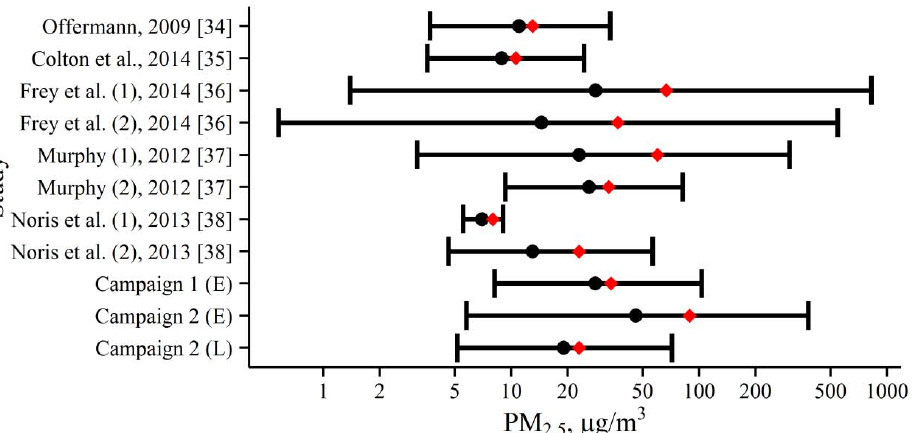
Figure 8. Summary of PM 2.5 concentrations measured in multi-family green buildings. Geometric mean (black circles), mean (red diamonds) and range containing 95 percent of the measurements (whiskers) are shown. Study labels are author (building if multiple green buildings in one study), year [reference]. Measurement methods used included 24-hour gravimetric filter samples (Offerman [34], Murphy [37]), DustTraks (Frey et al . [36], Noris et al . [38], this study), and 6–10 day integrated filter samples (Colton [35]).